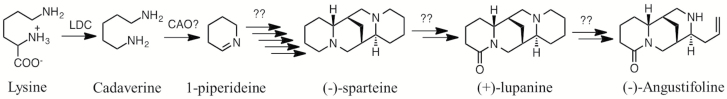
Core pathway towards the tetracyclic QAs in narrow-leafed lupin. LDC, lysine decarboxylase; CAO, cadaverine oxidase.